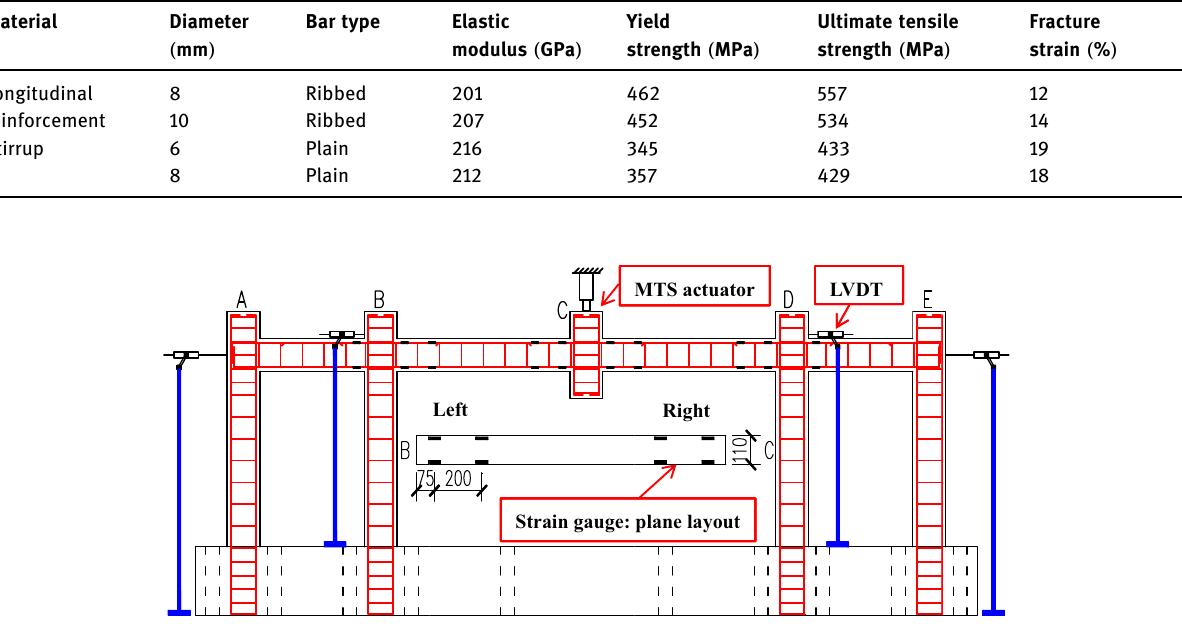
Figure 5: Layout of LVDTs and steel strain